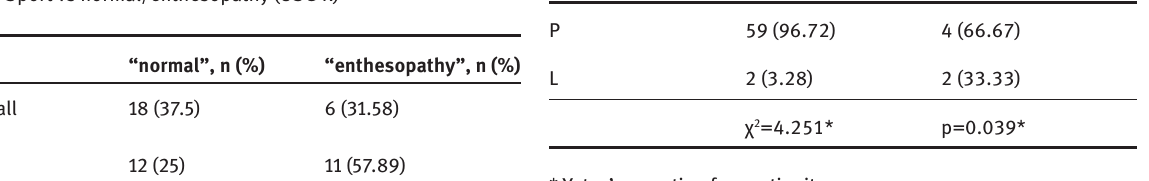
Figure 1: Irregular shape of humerał head (black arrow). Table 2: Sport vs normal/enthesopathy (USG R)